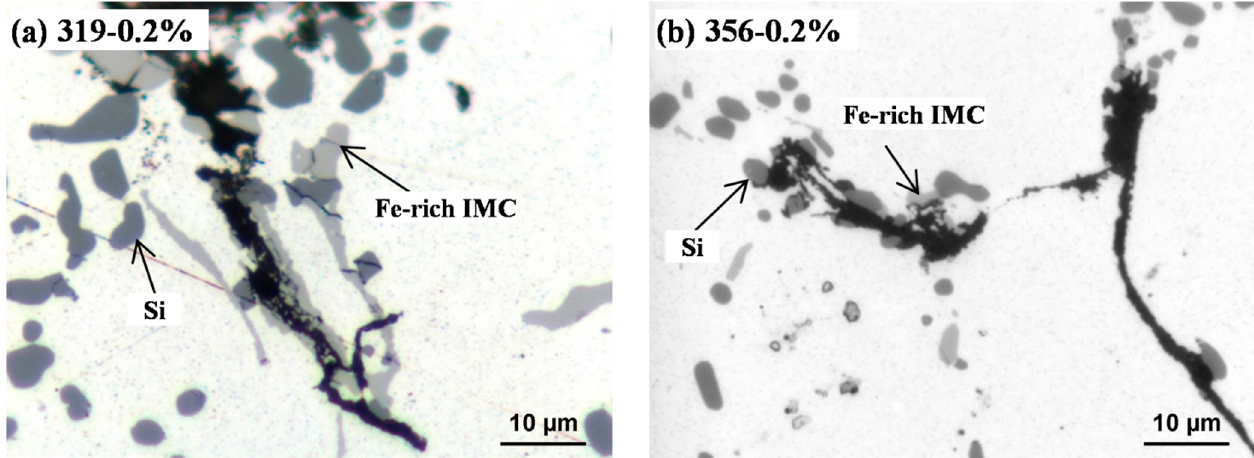
Figure 7. Optical cross-section images of the fracture surfaces showing the cracks in the ( a ) 319 al- loy and ( b ) 356 alloy after the 0.2% TMF test. Table 4. Microstructure characteristics of experimental alloys under T7 condition (before TMF).